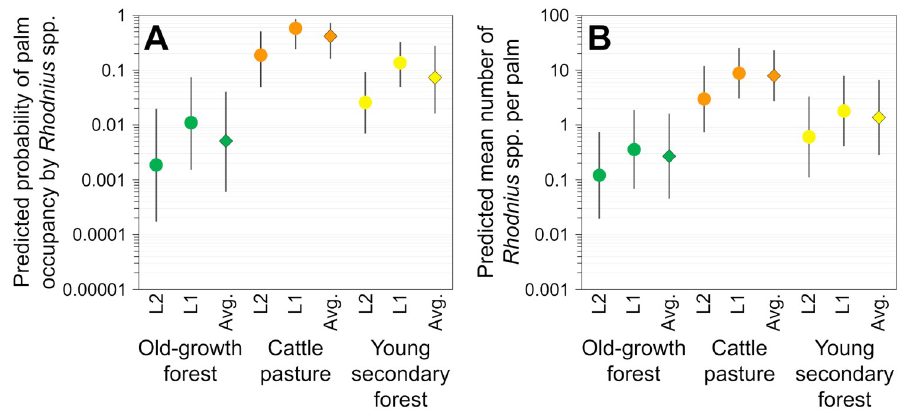
Fig 4. Effects of deforestation on adult Attalea palm occupancy (or infestation) by Rhodnius spp. (A) and on the number of Rhodnius spp. per palm (B) . The graphs show model-predicted probabilities of palm occupancy ( A ) and model-predicted mean number of bugs per palm ( B ) for three landscape classes in two localities (“L1” and “L2”) of eastern Amazonia. “Avg.” values (diamonds) are average predictions derived from simplified models without locality effects. All predictions are for “typical” palms with mean stem height (4.75 m) and mean organic score (0.73 units); note that the y -axes are on log10 scale. Error bars are 95% confidence intervals.